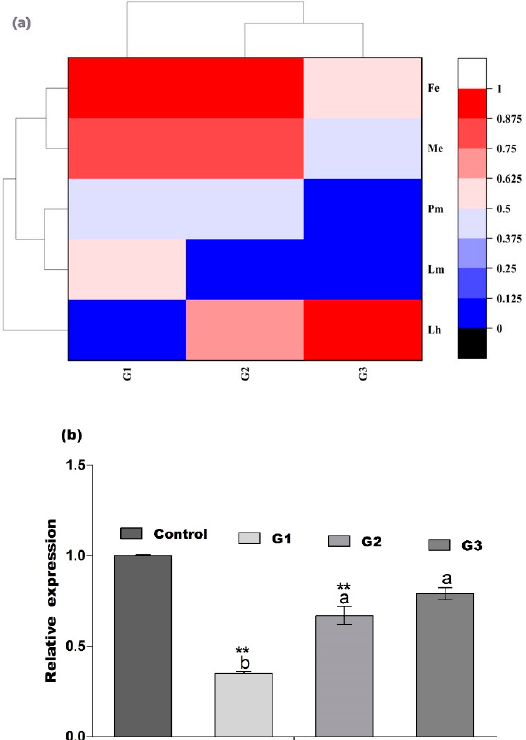
Figure 9. Five pairs of male and female adults were selected for G3 emerged from G2-generation. The percentage of the number of eggs per female, eggs hatched, larval mortality, pupal mortality, and adult male and female emergence were observed. Each point indicates the mean ± SD from CmHK and control groups. Significant differences are indicated by ** ( P < 0.05).